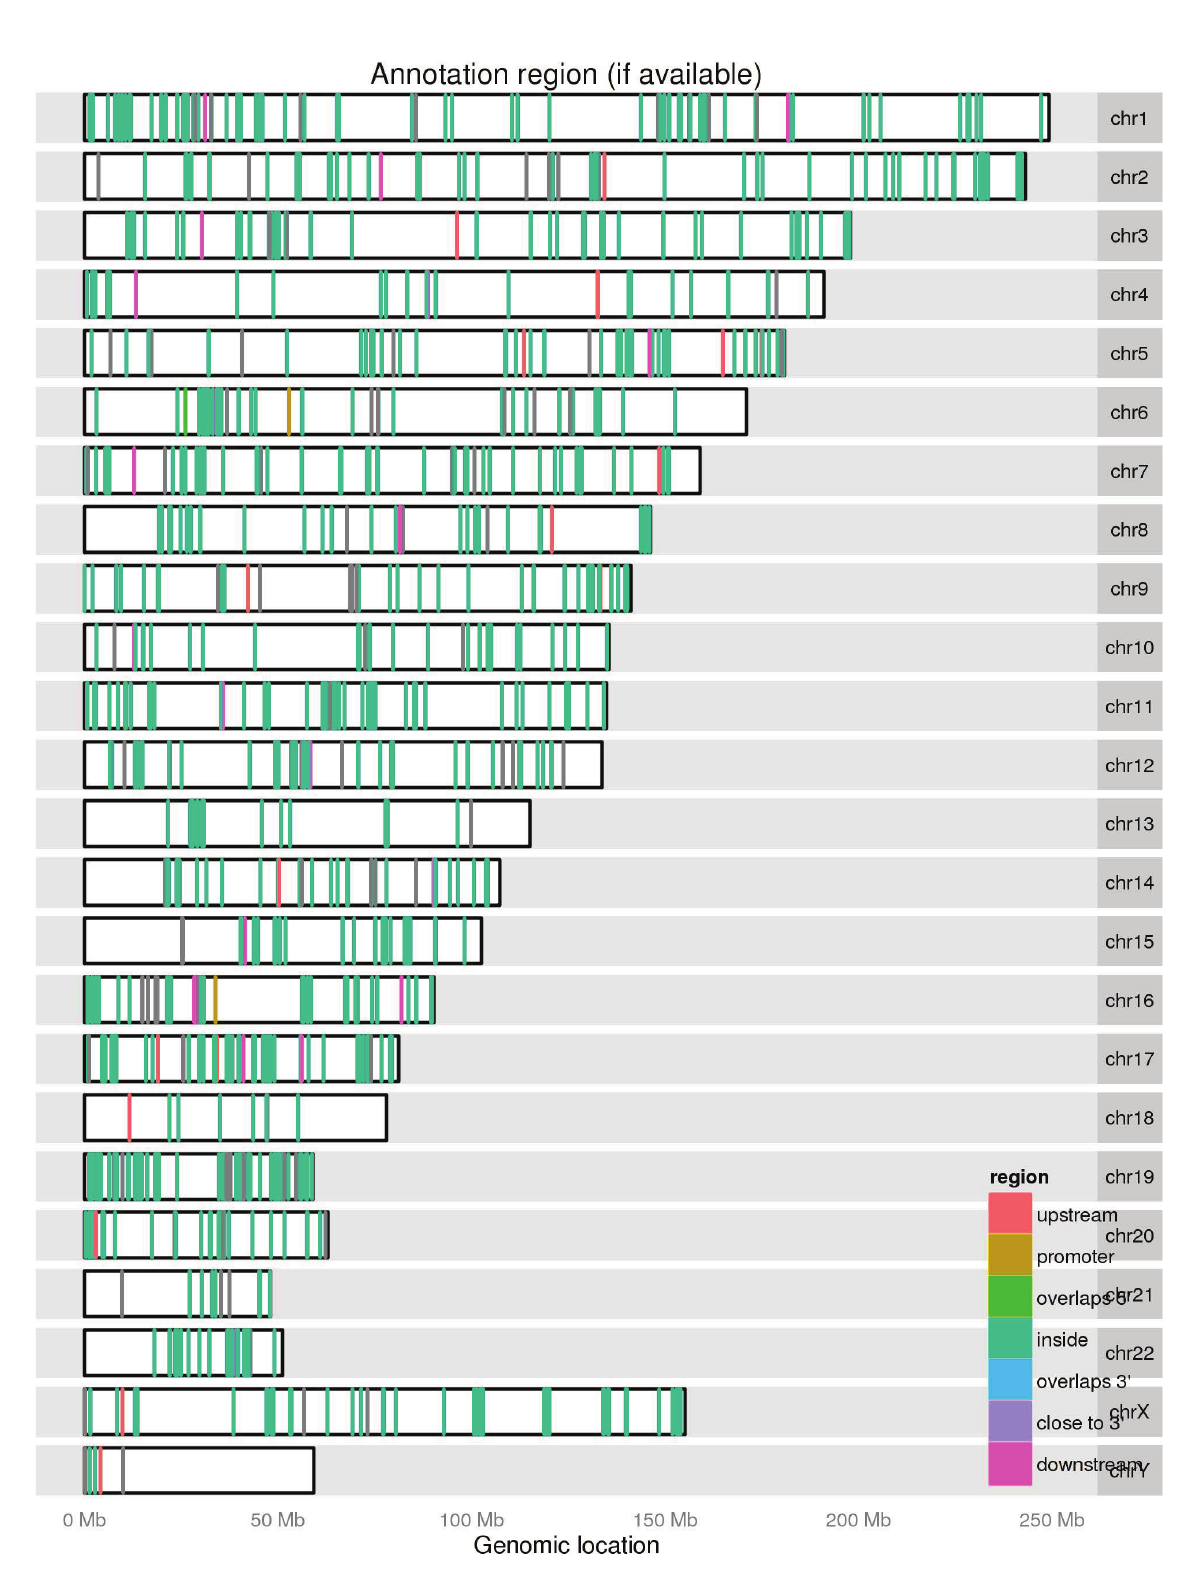
Figure 4. Genomic overview of the annotation type for the significant regions in the derfinder use case example with the Hippo